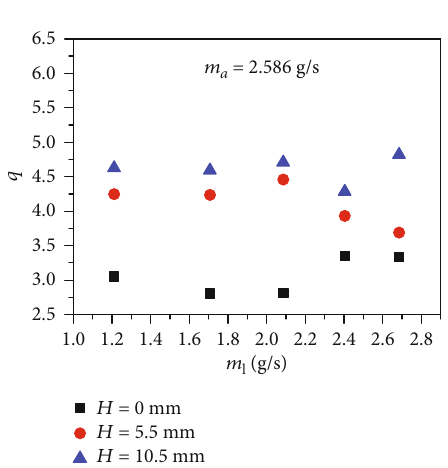
Figure 8: The drop size distribution parameter q of H series nozzle with various mass fl ow rates of fuel at air mass fl ow rate of ma = 2 : 586